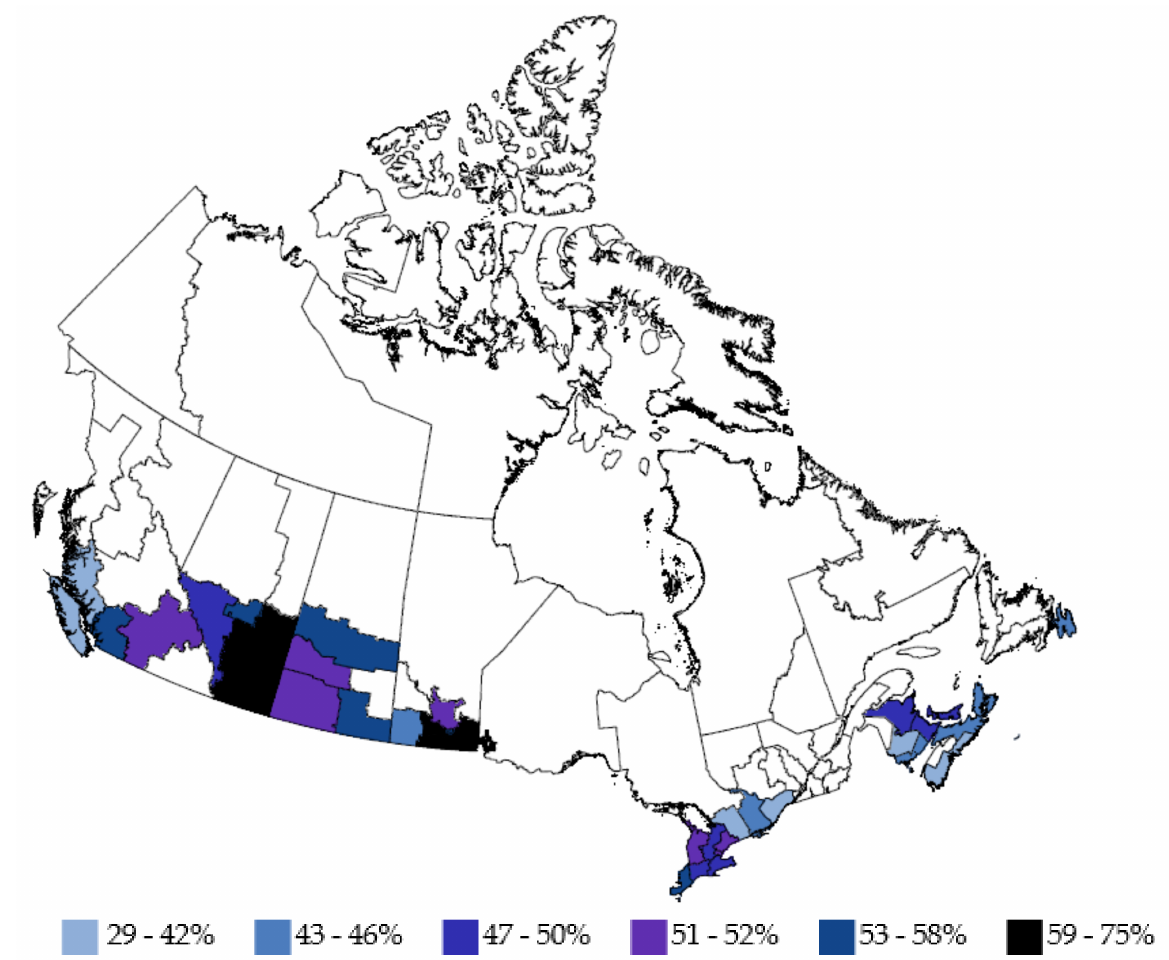
Figure 2. Anti-N seroprevalence in June 2022 by region. (White areas not tested/insufficient samples). Figure 3 shows the kernel density plots of the distribution and median anti-S con- centration by month in all anti-S positive donations by age group. The piecewise linear regression models identified two breakpoints in the 17–29, 30–40, 40–59-year-olds with